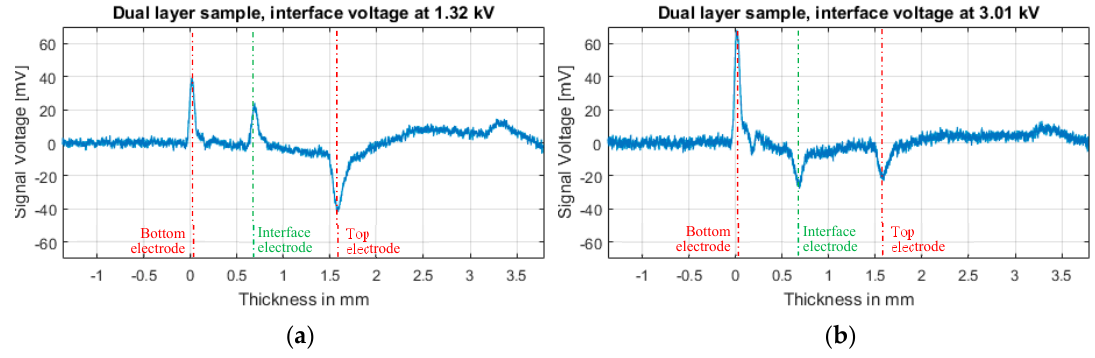
Figure 7. PEA signal without post-processing of 500 averaged signals, at 5 kV top electrode using the